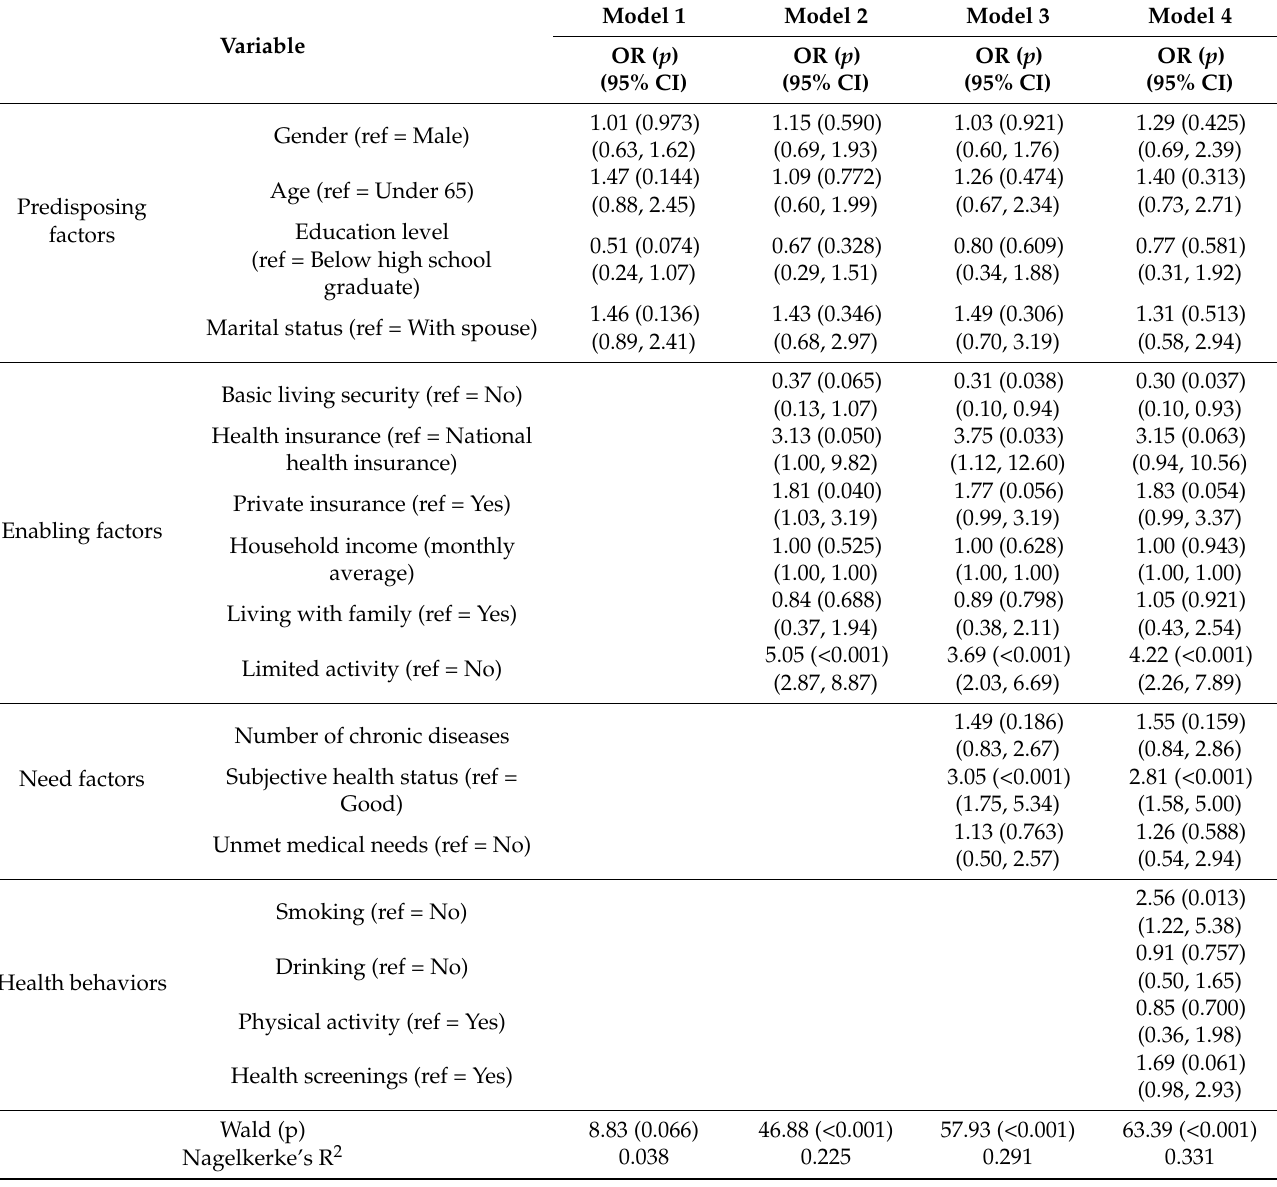
Table 4. Factors affecting usual activity dimension of health-related quality of life in patients with multimorbidity according to Andersen’s model (South Korea,